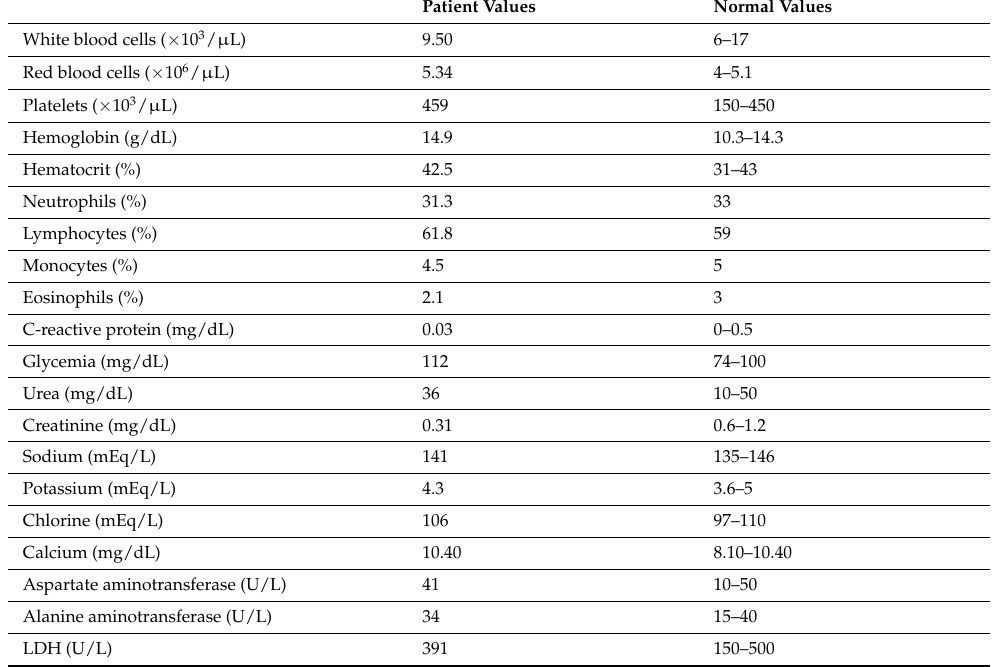
Table 1. Routine laboratory findings on